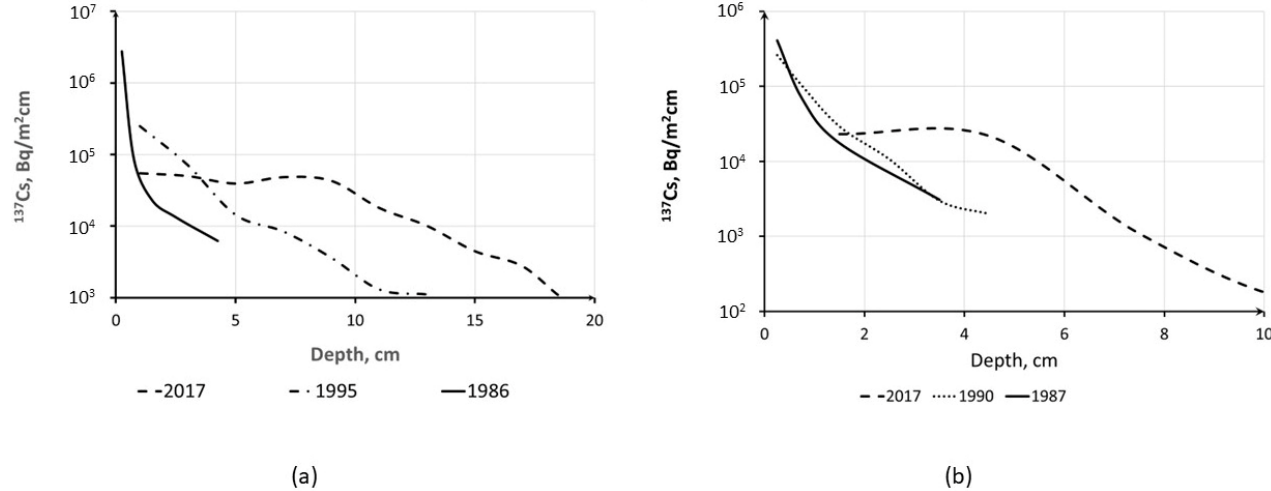
Figure 4. Long-term time changes in 137 Cs vertical distribution in soils of ChNPP exclusion zone nearby villages Benevka ( a ) for 1986–2017 and Korogod ( b ) for 1987–2017 [102]. Reprinted/adapted with permission from Ref. [102]. Copyright year 2020, copyright owner’s name SPRINGER Nature.